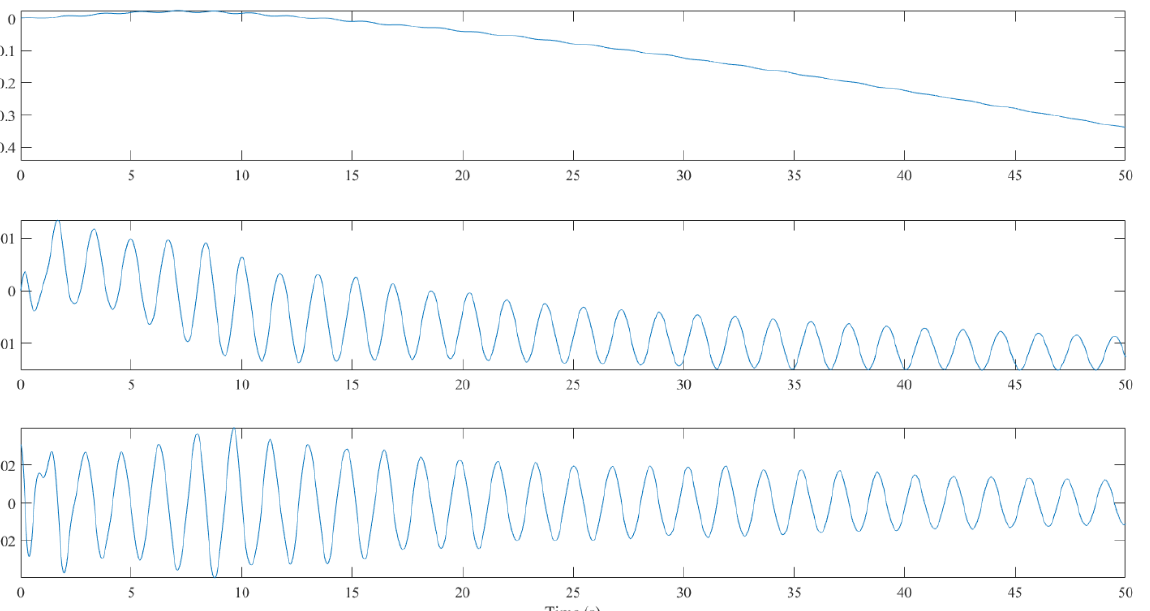
Figure 4. The vertical displacement, velocity, and acceleration time histories of the floating body under free vibration at an initial 5° pitch.